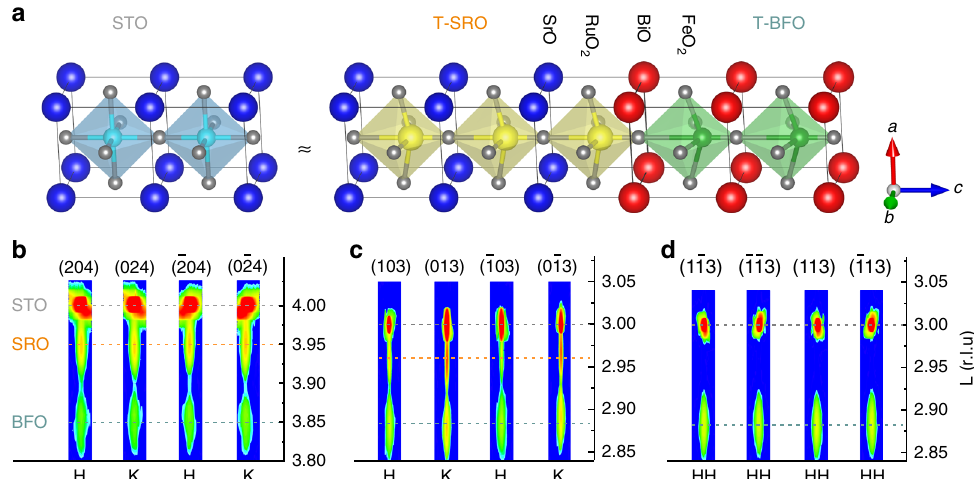
Fig. 5 Con fi rmation of tetragonal structure of SRO/BFO. a Schematic of tetragonal BFO on tetragonal SRO buffered (001) STO. b – d In-plane asymmetric reciprocal space mappings (RSM) around the {204} ( b ), {103} ( c ), and {113} ( d ), respectively. Bragg re fl ection is measured on SRO (7 nm)/BFO (12